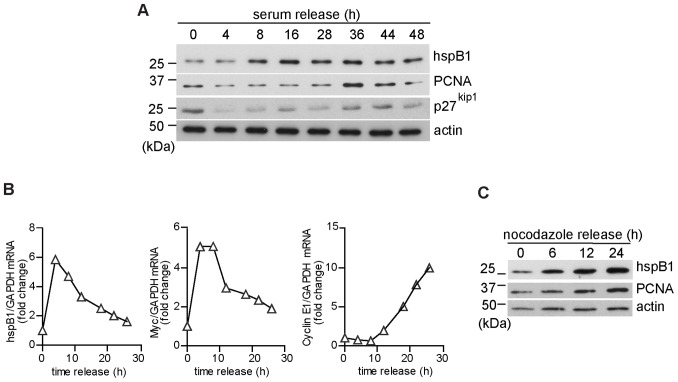
Expression of hspB1 protein and mRNA is controlled by the cell cycle.A, MEF were synchronized by serum starvation for 48% FCS-containing medium and analysed by western blot for hspB1, PCNA, p27kip1 and actin. B, Comparison of the expression of mRNAs for hspB1 and the cell cycle-regulated genes, Myc, and Cyclin E1 determined by qRT-PCR and normalized to GAPDH in a representative synchronized MEF serum release time course. C, Western blot for hspB1, PCNA and loading control, actin, in lysates of MEF following release from nocodazole G2/M block (40 ng/ml). All western blots shown are representative of at least two independent experiments.